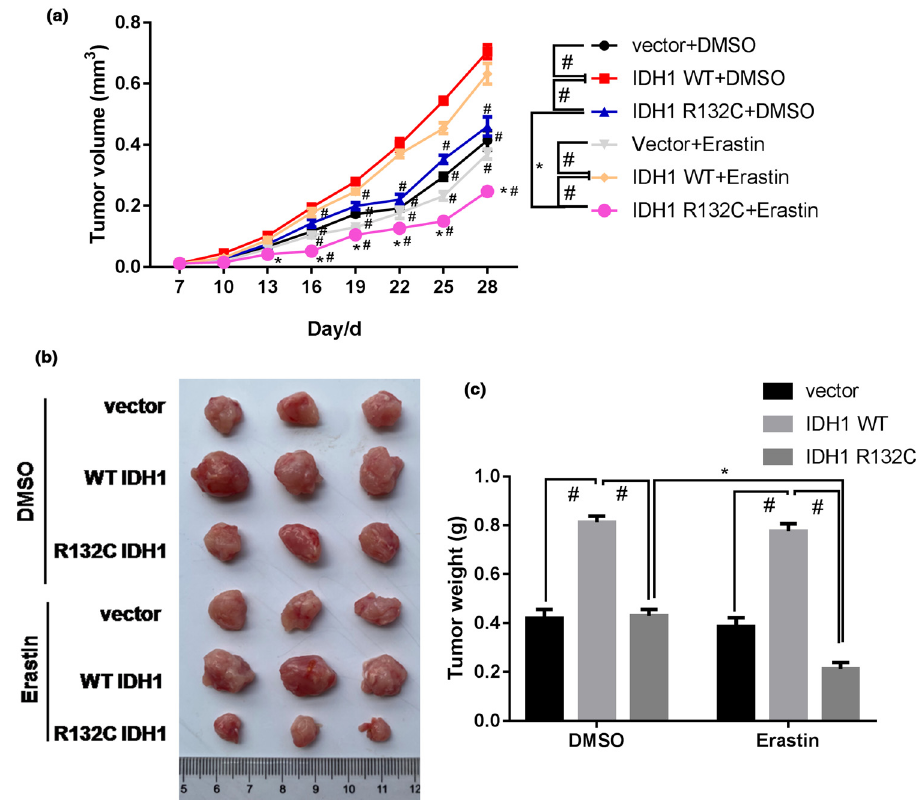
Figure 3: IDH1 mutation promotes erastin - induced tumor growth inhibition in cholangiocarcinoma. Male BALB/c nude mice were injected subcutaneously with IDH1 KO, WT, or mutation cell line. One week later, mice were injected intraperitoneally with erastin or DMSO at a dose of 15 mg/kg. ( a ) After administration, the diameter and volume of the tumor tissue were measured every 3 days until the end of the administration. The animals were executed and the tumor tissue was surgically removed for photography ( b ) , and for the measurement of ( c ) tumor weight. * p < 0.05 vs DMSO treatment group, # p < 0.05 vs IDH1 WT